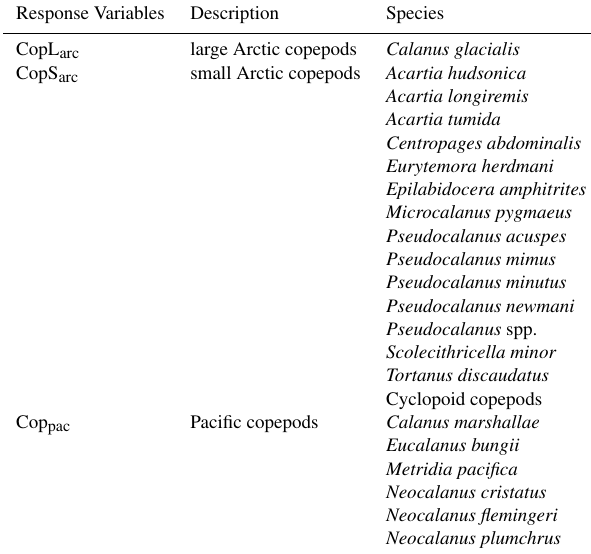
Table 2. The copepods species included in each copepod groups: large Arctic (CopL arc ) , small Arctic (CopS arc ) and Pacific (Cop pac )